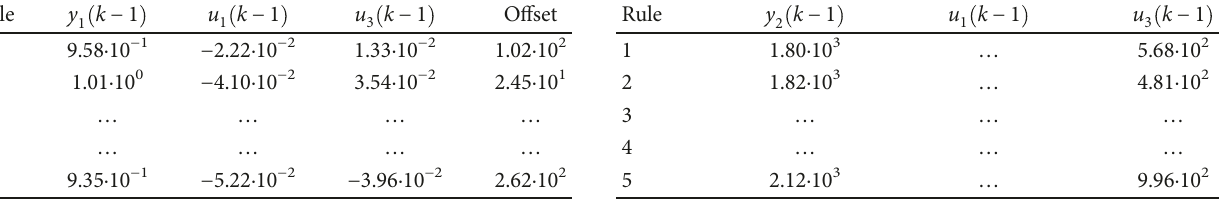
Table 7: Consequent parameters for biomass y